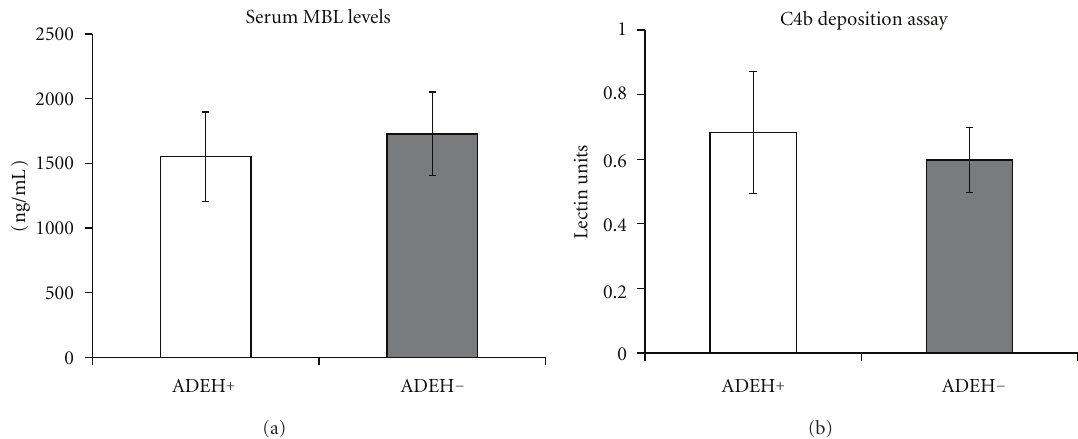
Figure 1: Mannan-binding lectin levels and activity in atopic dermatitis patients with and without a history of eczema herpeticum are not di ff erent. (a) Serum levels of MBL (ng/mL; ref. range > 200 ng/mL) and (b) MBL functional activity (lectin units; ref. range > 0 . 2 lectin units) in ADEH+ ( n = 13) or ADEH − ( n = 21) patients. Red line represents lower limit of the normal reference